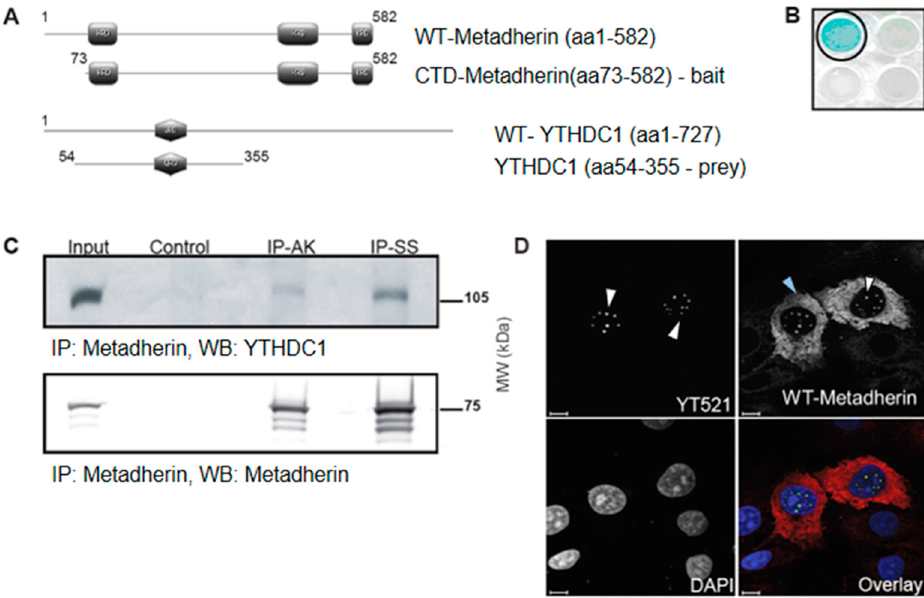
Figure 1. Metadherin interacts with YTHDC1 in the nucleus. ( A ) Schematic representation of metadherin (upper panel) and YTHDC1 constructs (lower panel). Lysine-rich domains (KRD) of metadherin shown in grey rectangles (top), and glutamine rich domain (QRD) of YTHDC1 shown in grey hexagon (bottom). ( B ) Yeast two-hybrid assay using pLexA-DIR-metadherin-aa73–582 (C-terminal domain (CTD)-metadherin) as bait and a human placental cDNA library. β -Galactosidase assay confirms interaction between YTHDC1 and metadherin, YTHDC1 well circled in black, adjacent wells show alternate targets which were all negative. ( C ) Endogenous metadherin was immunoprecipitated using two antibodies against a central epitope (IP-AK) and C-terminal epitope (IP-SS) with metadherin from 1 mg of COS7 protein lysate. Input is 10 µ g protein lysate, sheep IgG was used as control. Western blots were probed for YTHDC1 and metadherin (SS). Blots were visualised with enhanced chemiluminescent luminol-based (ECL) substrate plus or, when the signal exceeded the dynamic range of film, using 3,3’-Diaminobenzidine (DAB). ( D ) COS7 cells were fixed in methanol, probed with an anti-YTHDC1 (red) and anti-metadherin (green) antibodies, and mounted with DAPI (blue). White arrows show nuclear localization of the target protein, blue arrows indicate cytoplasmic localization. Images were obtained using a Nikon Eclipse confocal microscope using a × 100 objective. Scale bars represent 10 µm.